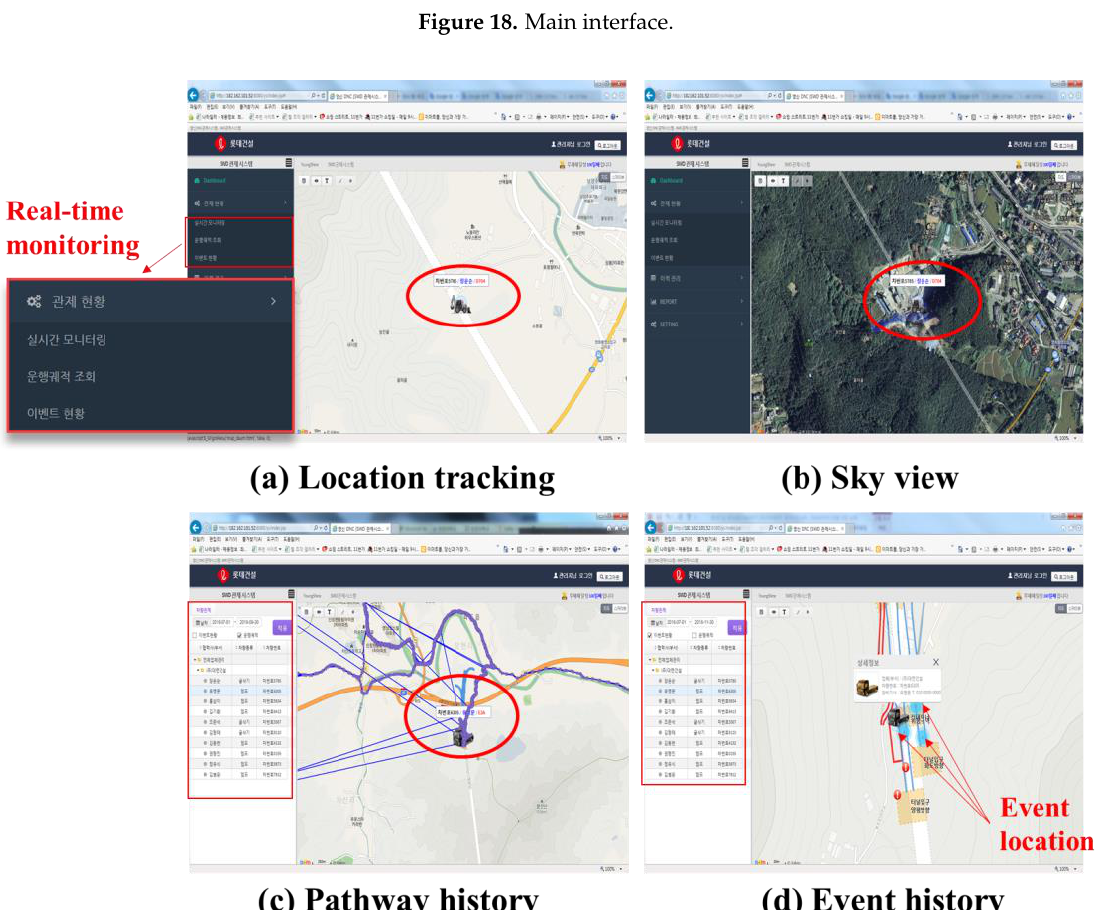
Figure 19. Real-time monitoring.